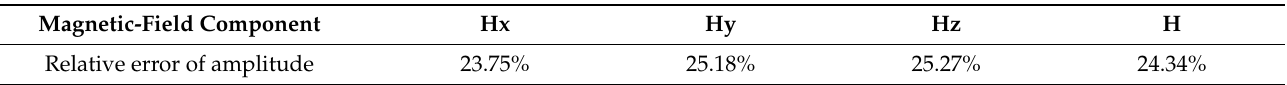
Table 2. Relative errors of magnetic field obtained by method of this article.